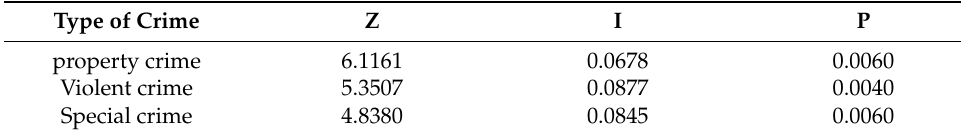
Table 1. Spatial autocorrelation results of various crime.